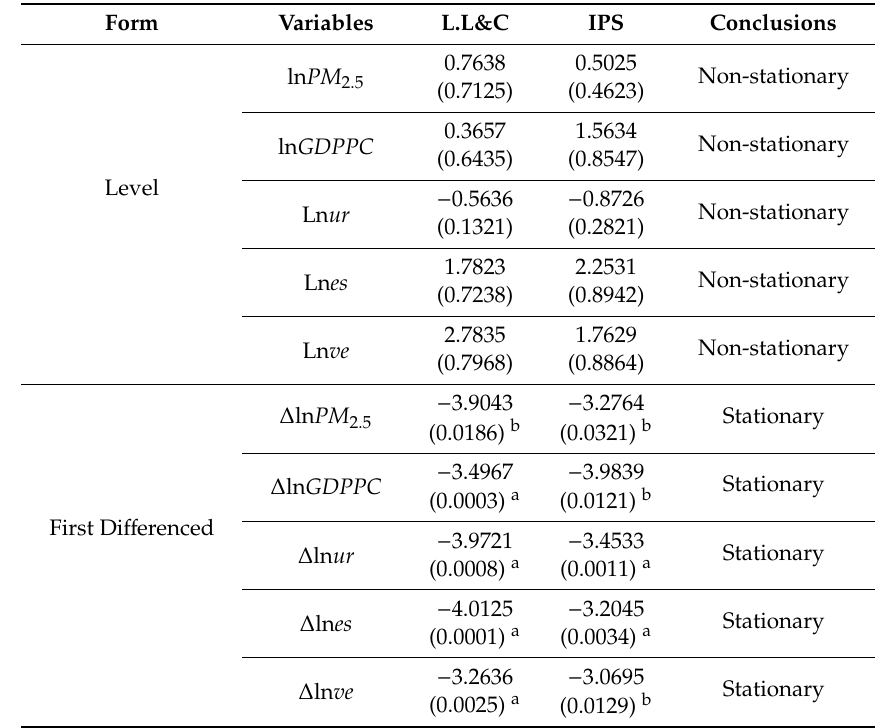
Table 4. Panel unit root examination results.